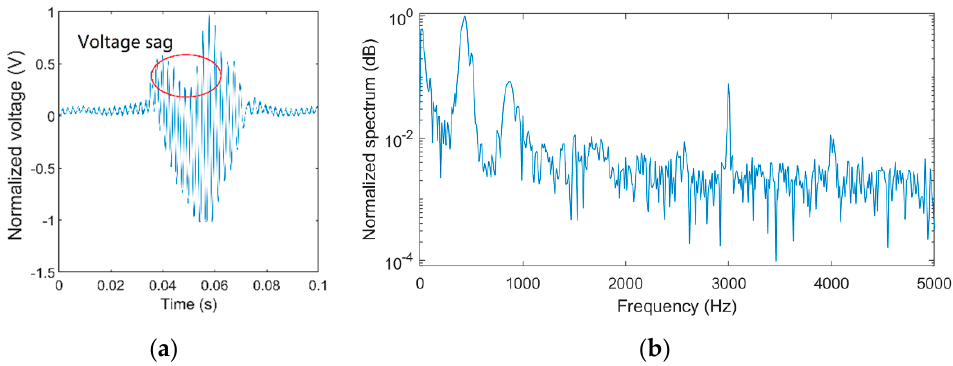
Figure 7. Common-mode disturbance on the 440 V battery pack charging cable after full charging in the ( a ) time domain and ( b ) frequency domain.